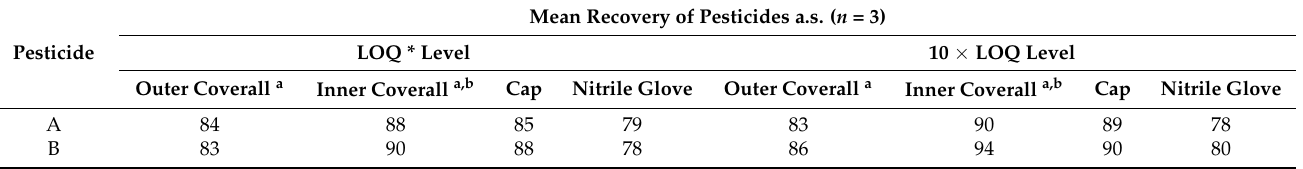
Table 3. Field spiking recovery results for a.s. bupirimate and